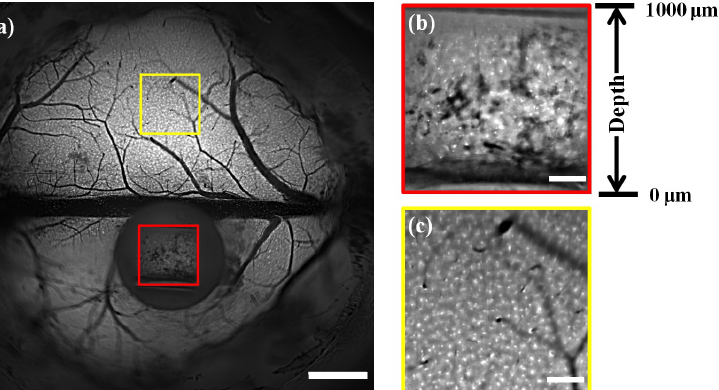
Figure 4. In vivo Cx3Cr1-GFP mouse brain imaging. ( a ) Large-FOV image of Cx3Cr1-GFP mouse brains using a custom-built wide-field fluorescence mesoscope. Scale bar: 1 mm. ( b , c ) Magnified views of the subregions in the longitudinal plane and superficial cortex marked in ( a ). Scale bar: